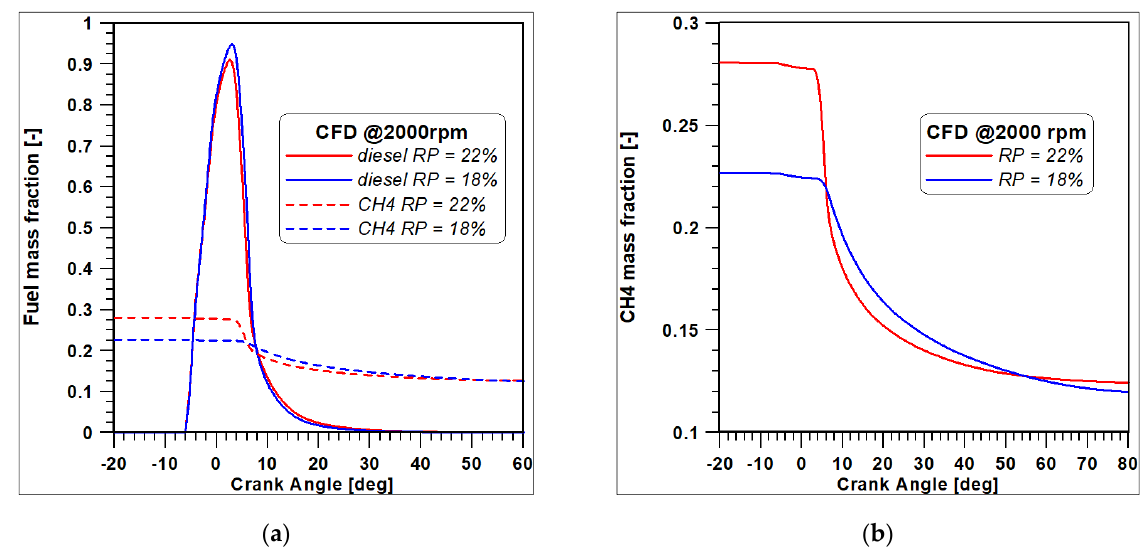
Figure 15. ( a ) Mass fractions of n-dodecane and methane comparison for RP = 22 and 18% at 2000 rpm; ( b ) Methane mass fraction comparison for RP = 22 and 18% at 2000 rpm.